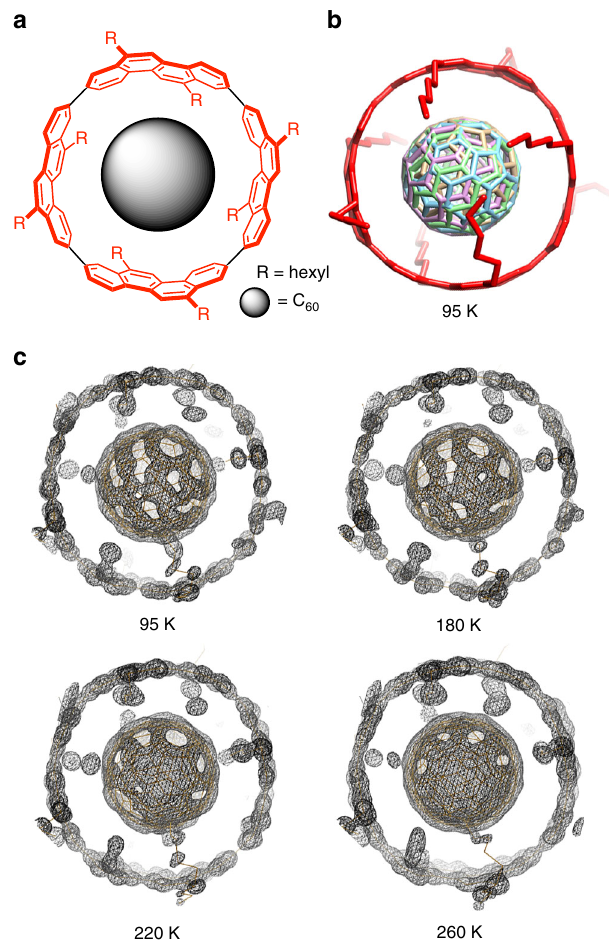
Fig. 1 Variable-temperature crystallographic analyses of ( P )-(12,8)-[4] CC ⊃ C 60 . a Molecular structure shown in the chemical diagrams. b A crystal structure at 95 K, shown in tube models. Four disordered C 60 orientations are shown in different colors. Disordered alkyl chains and hydrogen atoms are omitted for clarity. c Temperature-dependent electron